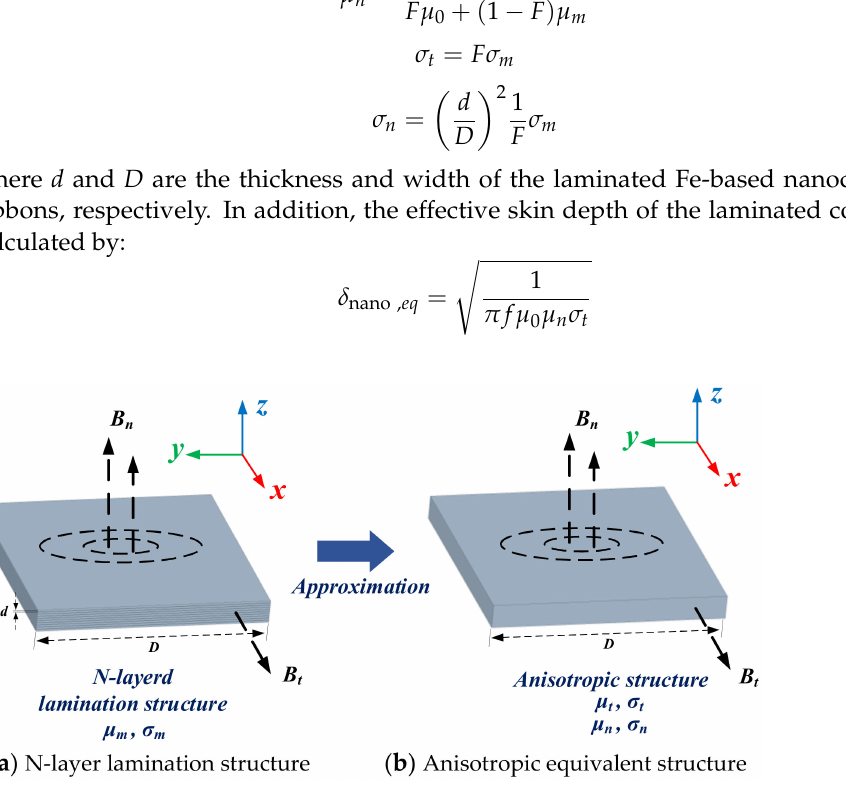
Figure 20. ( a , b ) Homogeneous medium approximation method for the magnetism of laminated materials. Therefore, compared with ferrite cores, the magnetic flux distribution within the cross-sectional area of nanocrystalline cores is not uniform. Since the permeability in the parallel and perpendicular directions is very different with respect to the ribbon, the parallel direction ( x -axis) is the preferred magnetic path for the magnetic flux. The vertical direction ( y -axis) represents a high reluctance path due to the ribbons between the adhesives [187]. Therefore, when using nanocrystalline materials as the magnetic coupler cores, the vertical arrangement, as shown in Figure 21, can be considered to adapt to the magnetic circuit direction of the circular or DD